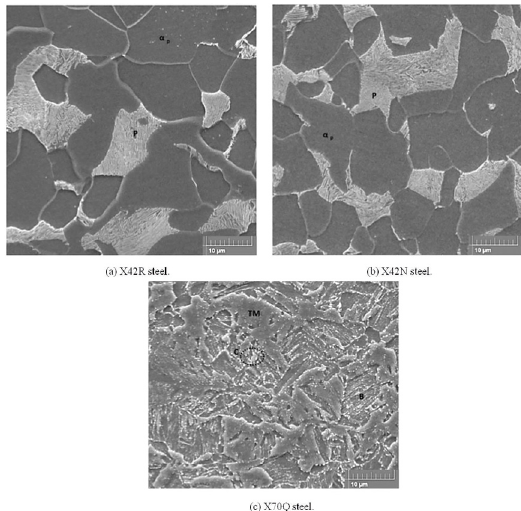
Figure 1. SEM micrographs, longitudinal section. Nital 2% etching. αp = polygonal ferrite; P = pearlite; TM = tempered martensite; B = bainite; C = cementite